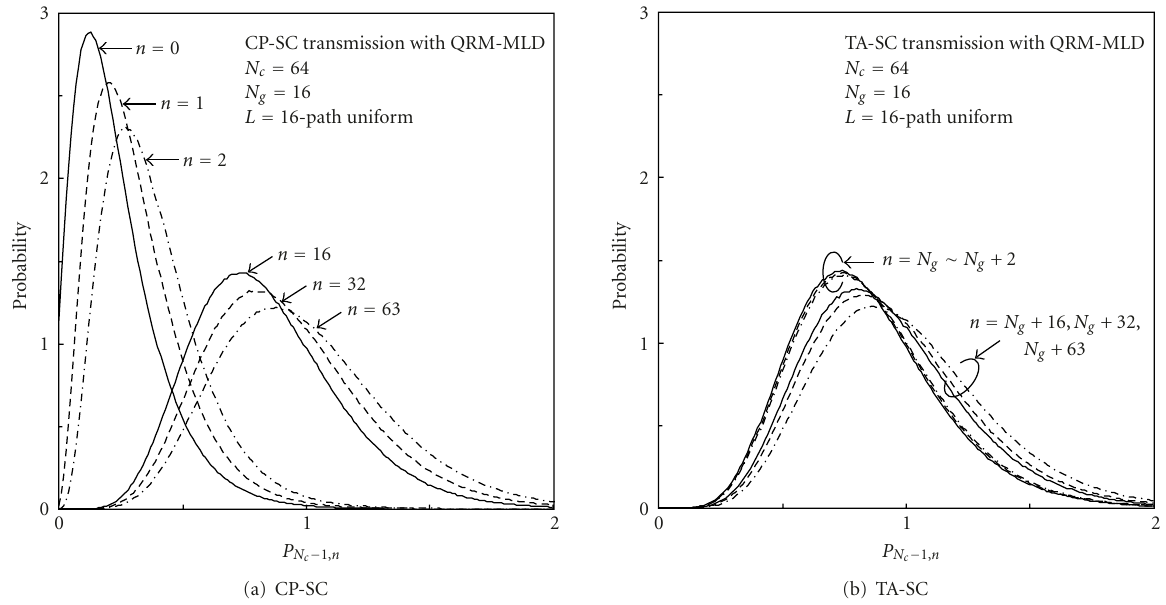
Figure 5: Pdf of the received signal power associated with the symbol d ( N c − 1) at the n th stage.